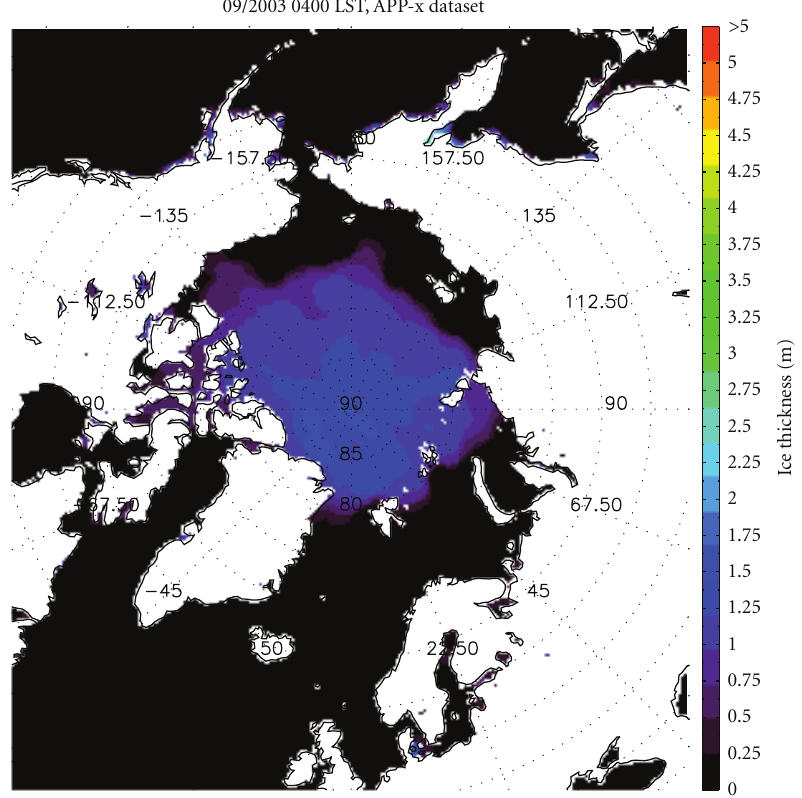
Figure 12: Spatial distribution of the monthly mean sea ice thickness for September 2003 retrieved by OTIM with APP-x data set for the Arctic Ocean north of 60 ◦